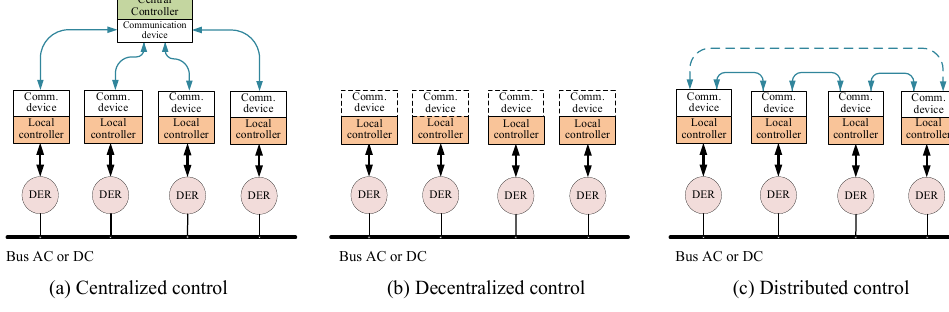
Figure 7. Approaches to microgrid control.